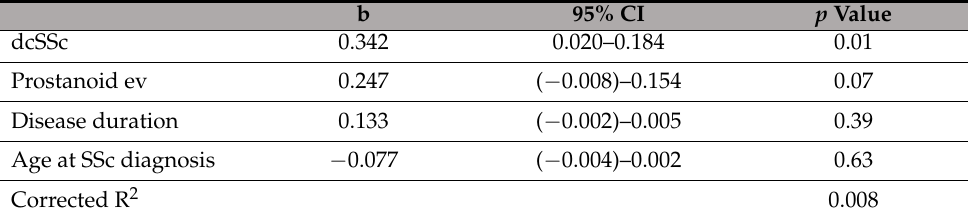
Table 3. Independent Effects of Clinical Variables on